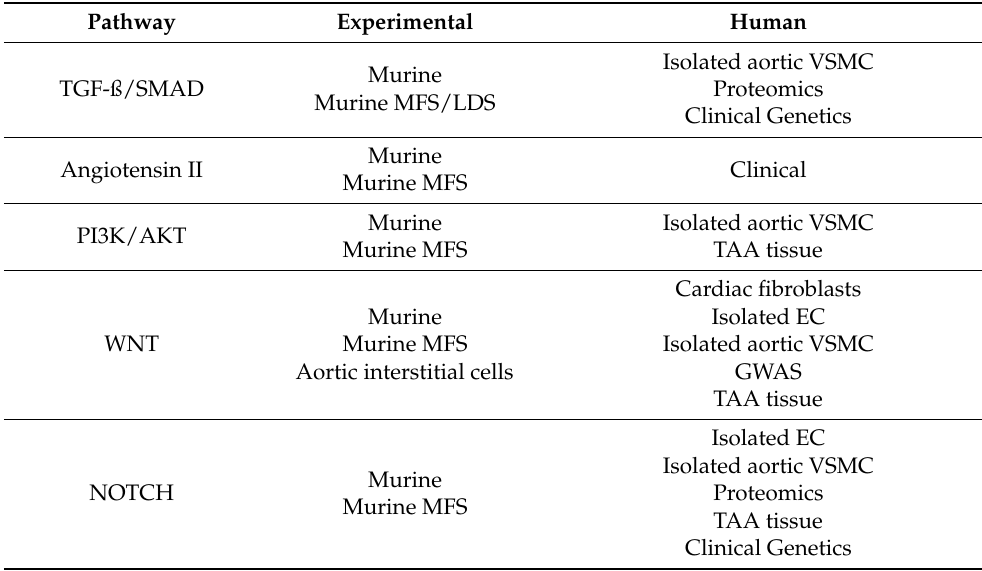
Proteomics TAA tissue Clinical